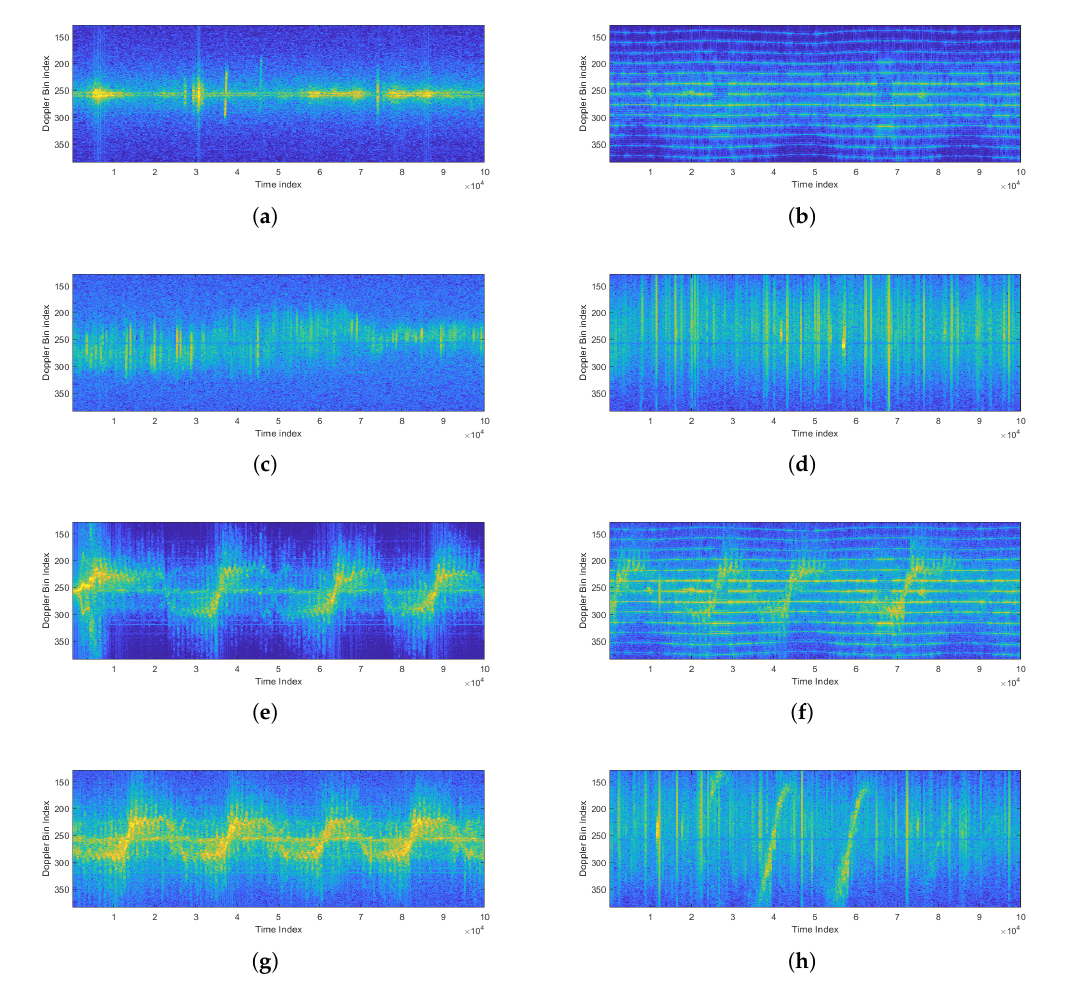
Figure 6. The micro-Doppler spectrograms of eight types. These show the spectrogram images during about 90 s. From these spectrograms, we can understand the frequency characteristics of each class. The signal by an electric fan has harmonic frequencies and the signals by snow and rain are relatively broadband frequency characteristics. In the case of the human walking signal, it can be aware that the signal intensity returned by torso is stronger than other parts. Therefore, it shows that it is possible to classify classes using the frequency characteristics of a signal instead of spectrogram images. ( a ) Outdoor environment (LoS); ( b ) Fan; ( c ) Snow; ( d ) Rain; ( e ) Human walking; ( f ) Human walking with fan; ( g ) Human walking with snow; ( h ) Human walking with